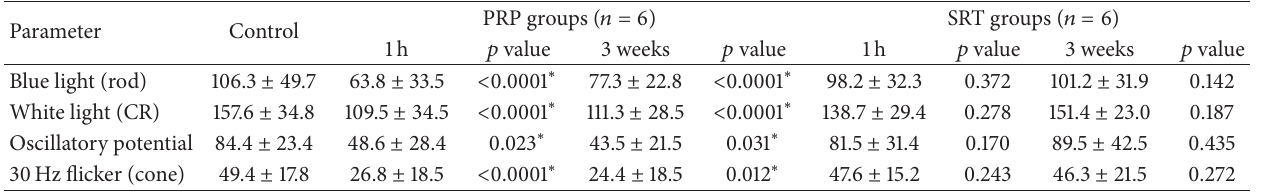
Table 2: Full-field electroretinography